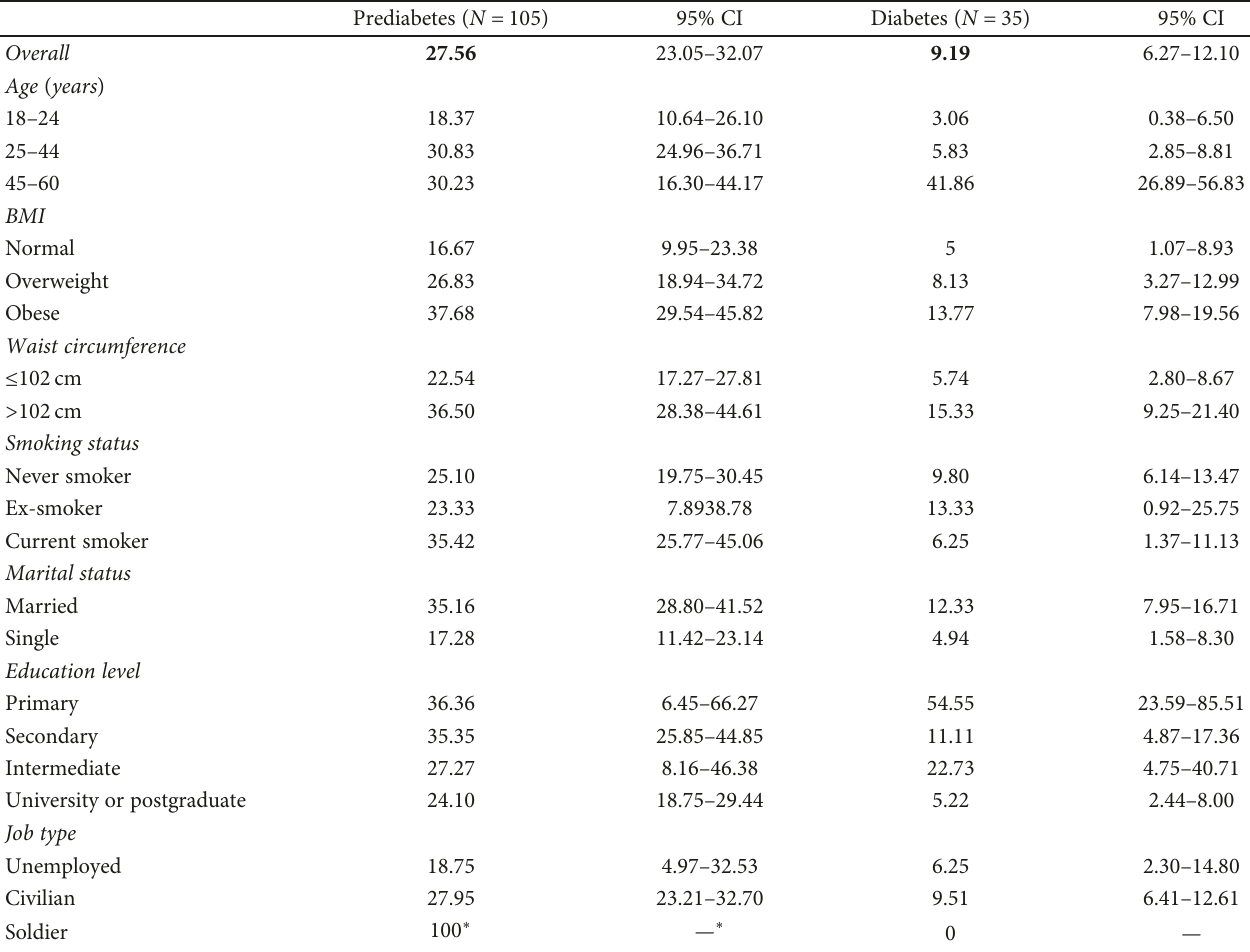
Table 2: Crude prevalence and trait-speci fi c prevalence of diabetes and prediabetes in male Al-Kharj population.